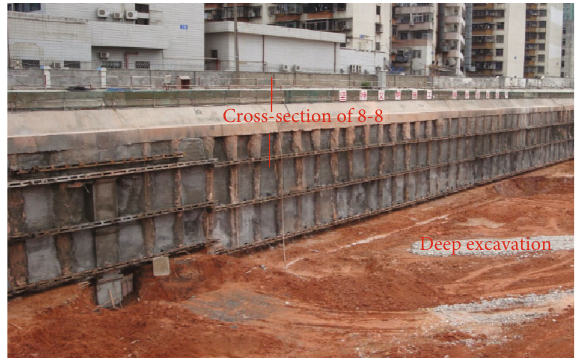
Figure 1: Construction photo of the pile-anchor structure at the west side of